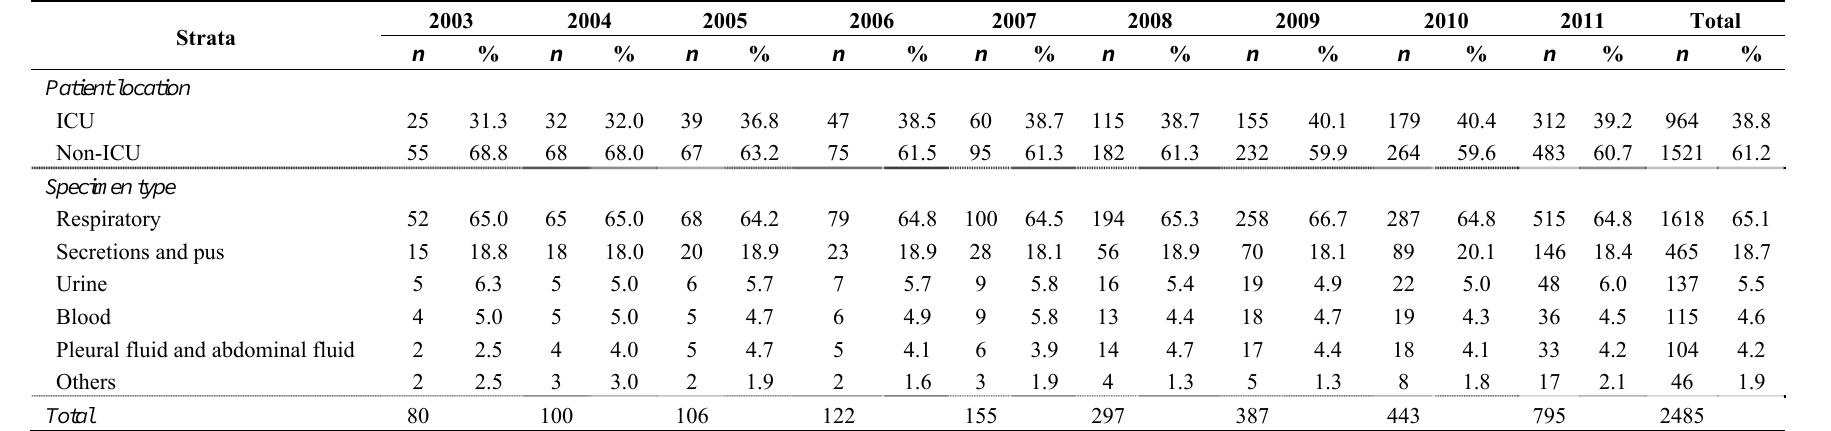
Table 1. Source breakdown of A. baumannii complex isolated from First Hospital of Jilin University, 2003–2011.